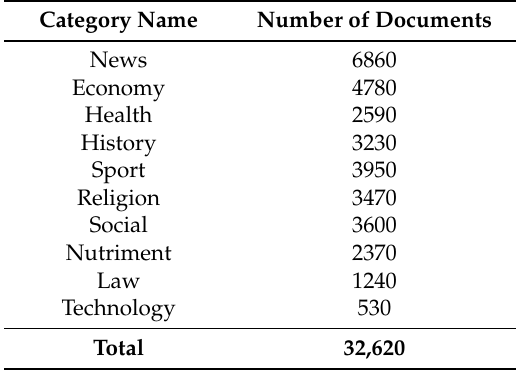
Table 4. Statistics of the documents in the corpus.